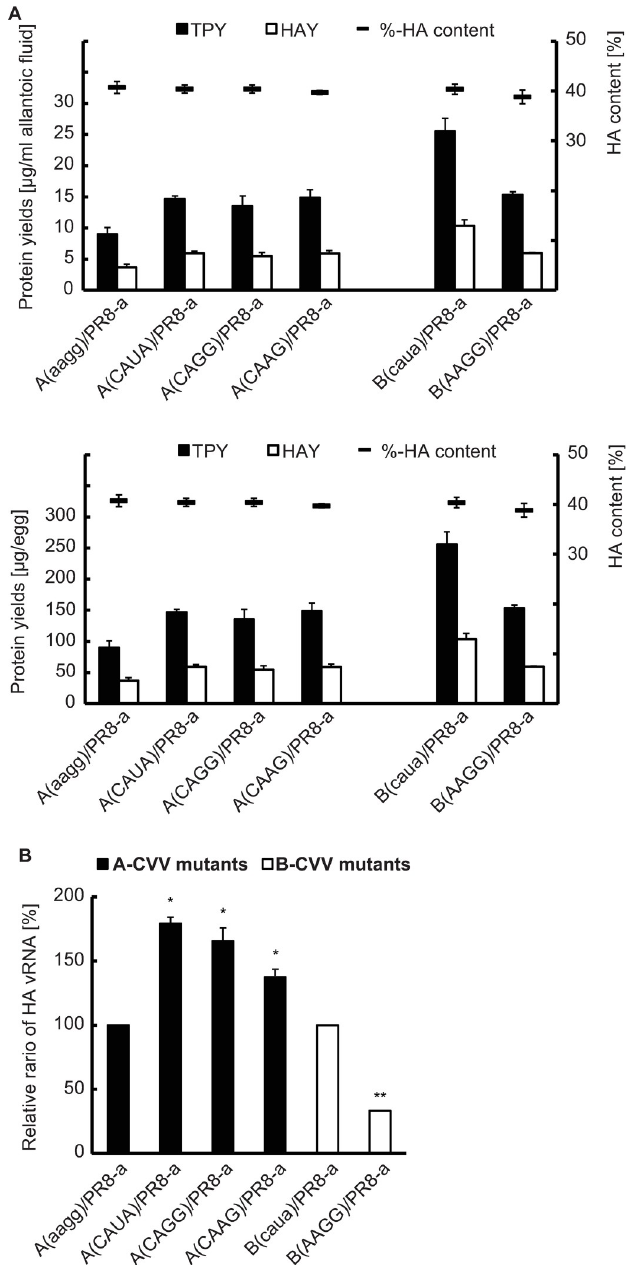
Fig 4. Characterization of 3’NCR/HA mutants. (A) Average total protein yield (TPY), average HA antigen yield (HAY) and average %-HA content of each mutant. (B) Relative HA vRNA ratio of each mutant. The vertical axis indicates the ratios of vRNAs to A(aagg)/PR8-a and B(caua)/PR8-a. A single asterisk and double asterisks indicate significant differences ( P < 0.01) from the value of A(aagg)/PR8-a and the value of B(caua)/PR8-a, respectively. The differences in the TPY, HAY, %-HA content and the relative HA vRNA ratio were statistically analyzed using Tukey’s HSD method. The values are presented as the mean values with standard deviations from three independent